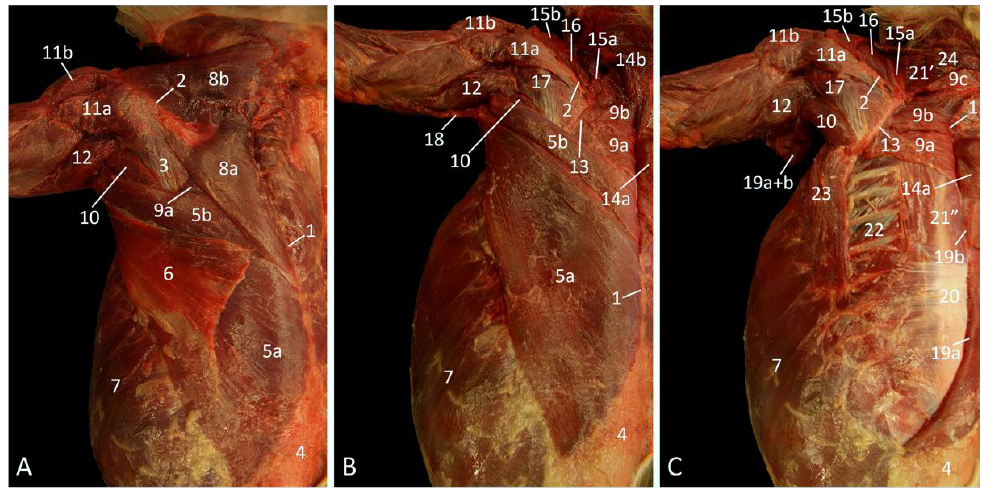
Figure 1. Dorsal view of the junctional musculature between the left thoracic limb and the thorax. ( A ): Superficial layer; ( B ): Middle layer, after the m. cutaneus trunci has been removed and the m. trapezius was retracted; ( C ): Deepest layer, after the removal of the m. latissimus dorsi and the m. trapezius pars cervicalis.